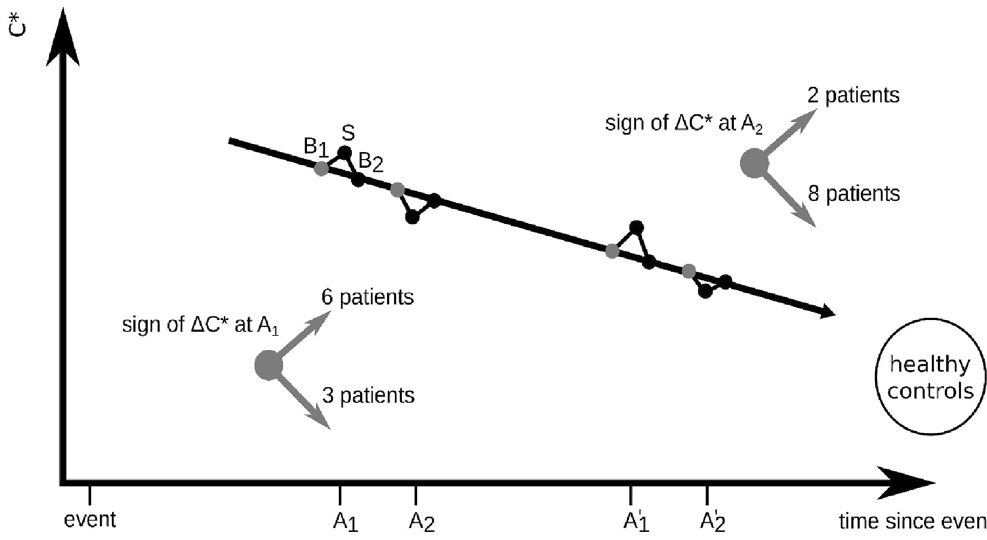
Figure 6. Proposed model of short-term and long-term stimulation-induced modifications of evolving functional brain networks in patients with an unresponsive wakefulness syndrome. The black arrow indicates a long-term treatment effect due to continued rehabilitation complex treatment as monitored with age-corrected average clustering coefficient C * at different assessments ( A1 , A2 ). Short-term modifications can be monitored with changes of C * (Δ C *) while evolving functional brain networks transit from a baseline period at rest ( B1 ) to a period of sensory stimulation ( S ) and back to a baseline period at rest ( B2 ). A negative change (Δ C * < 0